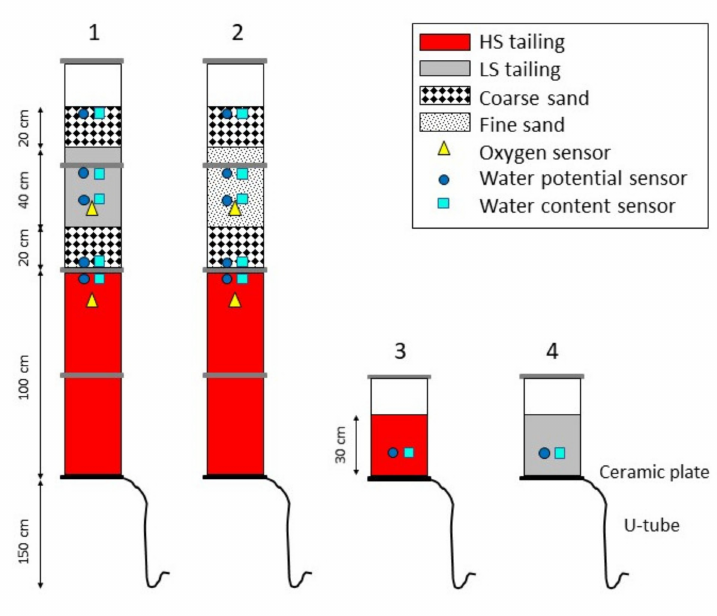
Figure 4. Instrumented columns design. Location of oxygen sensors (yellow triangles), water potential sensors (blue circles), and volumetric water content sensors (cyan squares) are